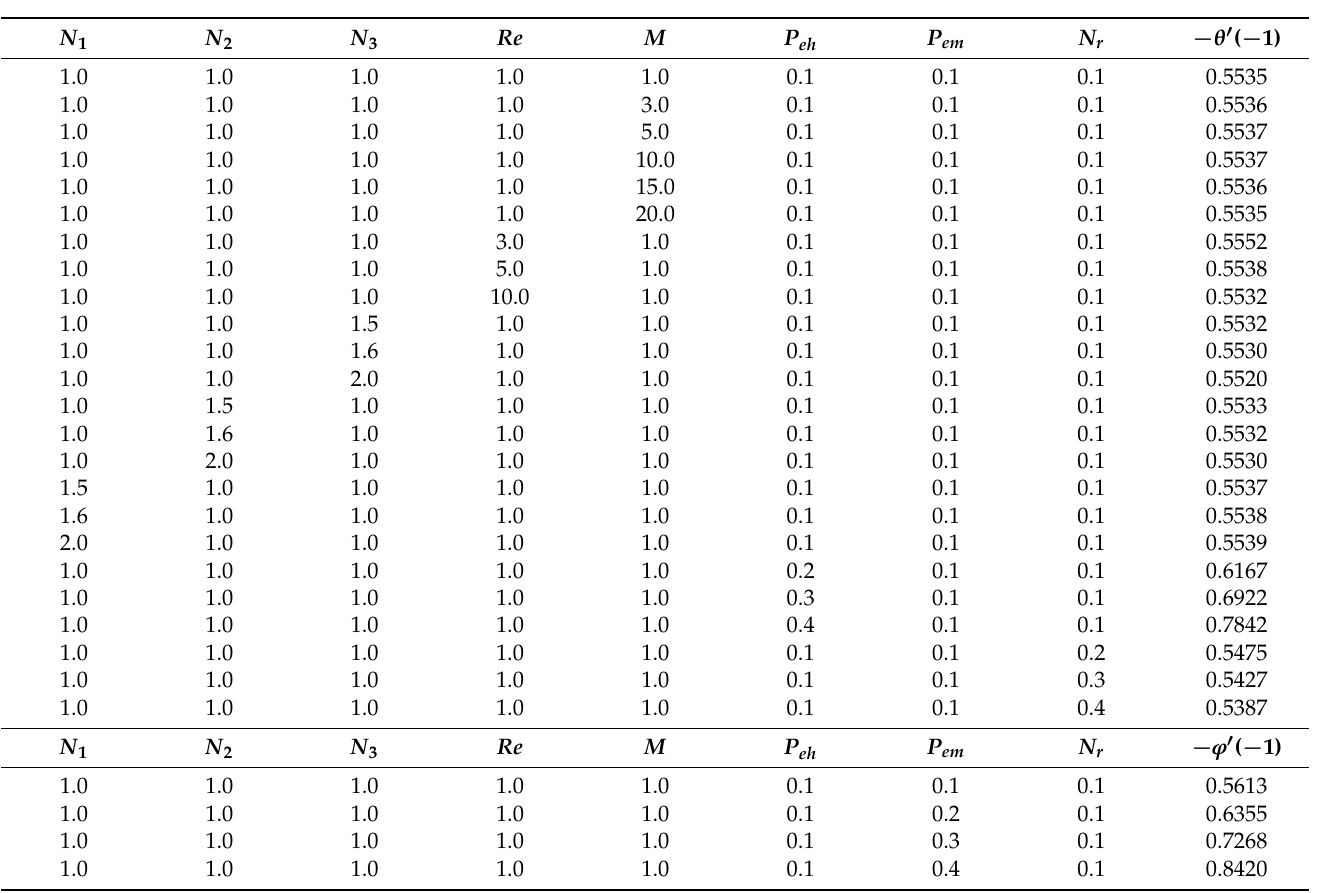
Table 1. Numerical values of − θ (cid:48) ( − 1) and − ϕ (cid:48) ( − 1) for different values of N 1 , N 2 , N 3 , Re , M P eh , P em and Nr